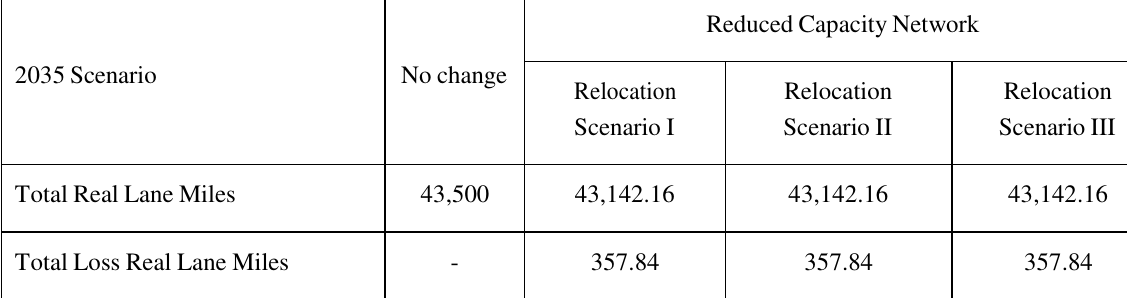
Table 2 Summary of the model results for the total loss of lane miles under relocation